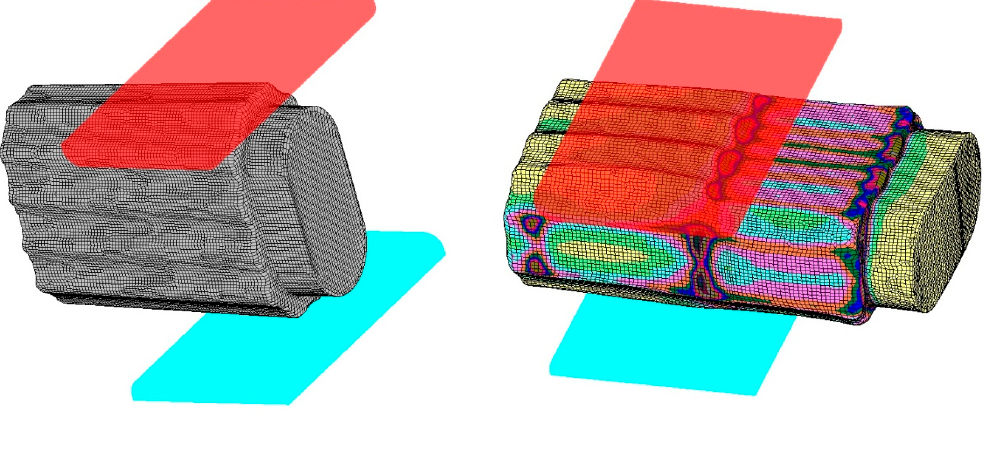
Figure 3. Forging process of a polygonal shape of surfaces of the P40N slab ingot to flat surfaces of billet. ( a ) Initial shape of the P40N ingot; ( b ) Flat surfaces billet; ( c ) The billet of 1550 mm width × 900 mm thickness.